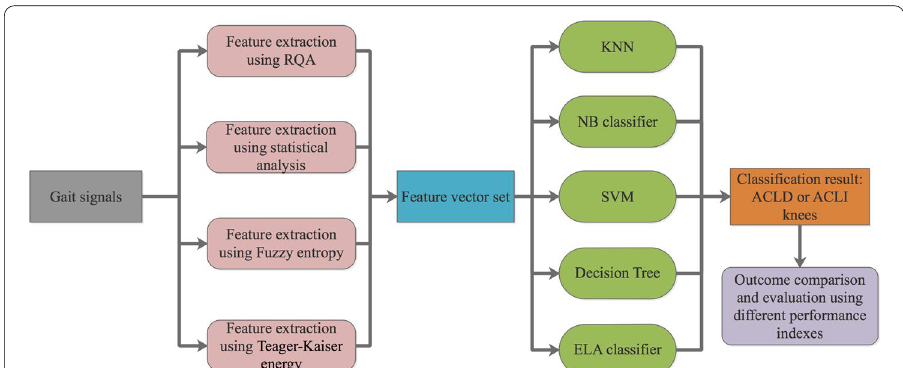
Fig. 1 Block diagram of the proposed method for the discrimination of ACLD and ACLI knees using different features and classification models